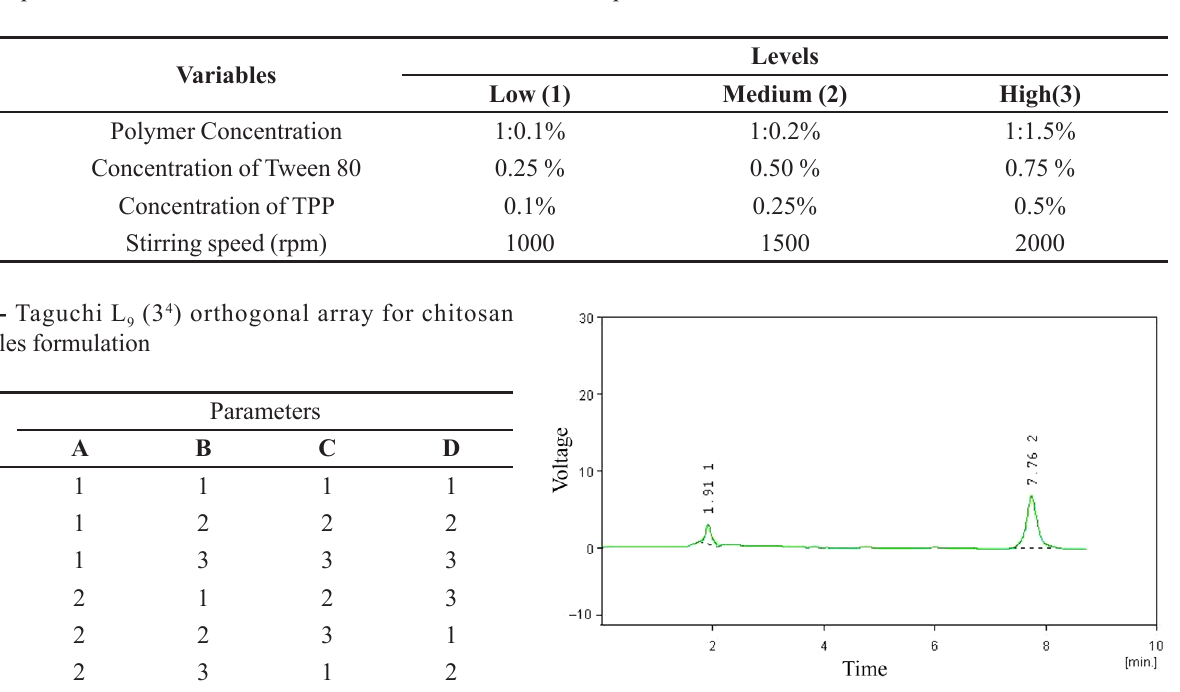
TABLE I - Experimental control factors and their levels for chitosan nanoparticles formulation